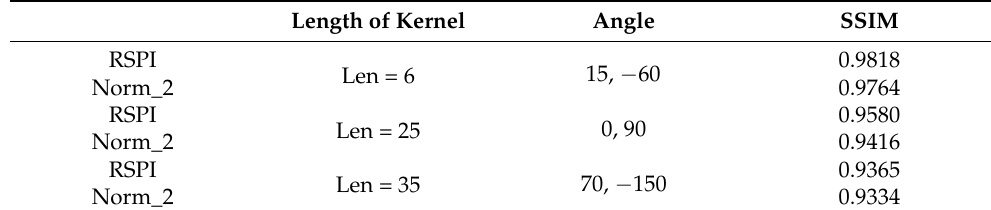
Table 1. Example of the method with RSPI.